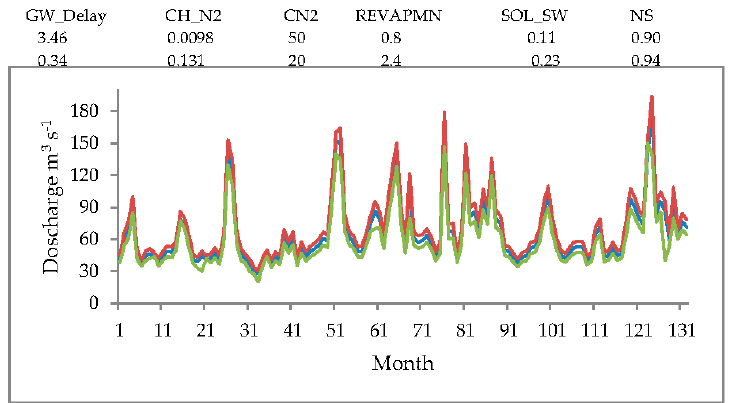
Figure 7. Example of parameter non ‐ uniqueness showing two similar discharge signals based on quite different parameter values.